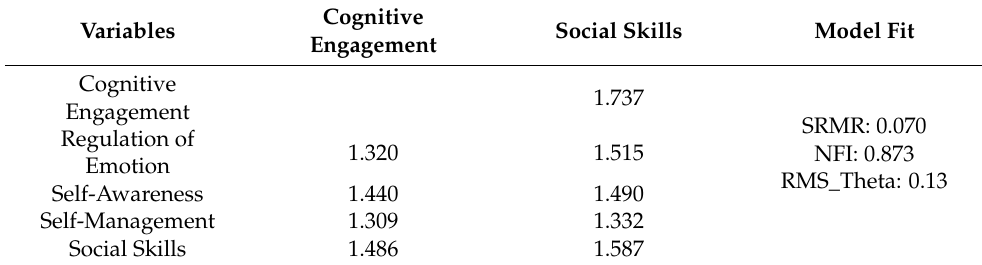
Table 4. Collinearity and model